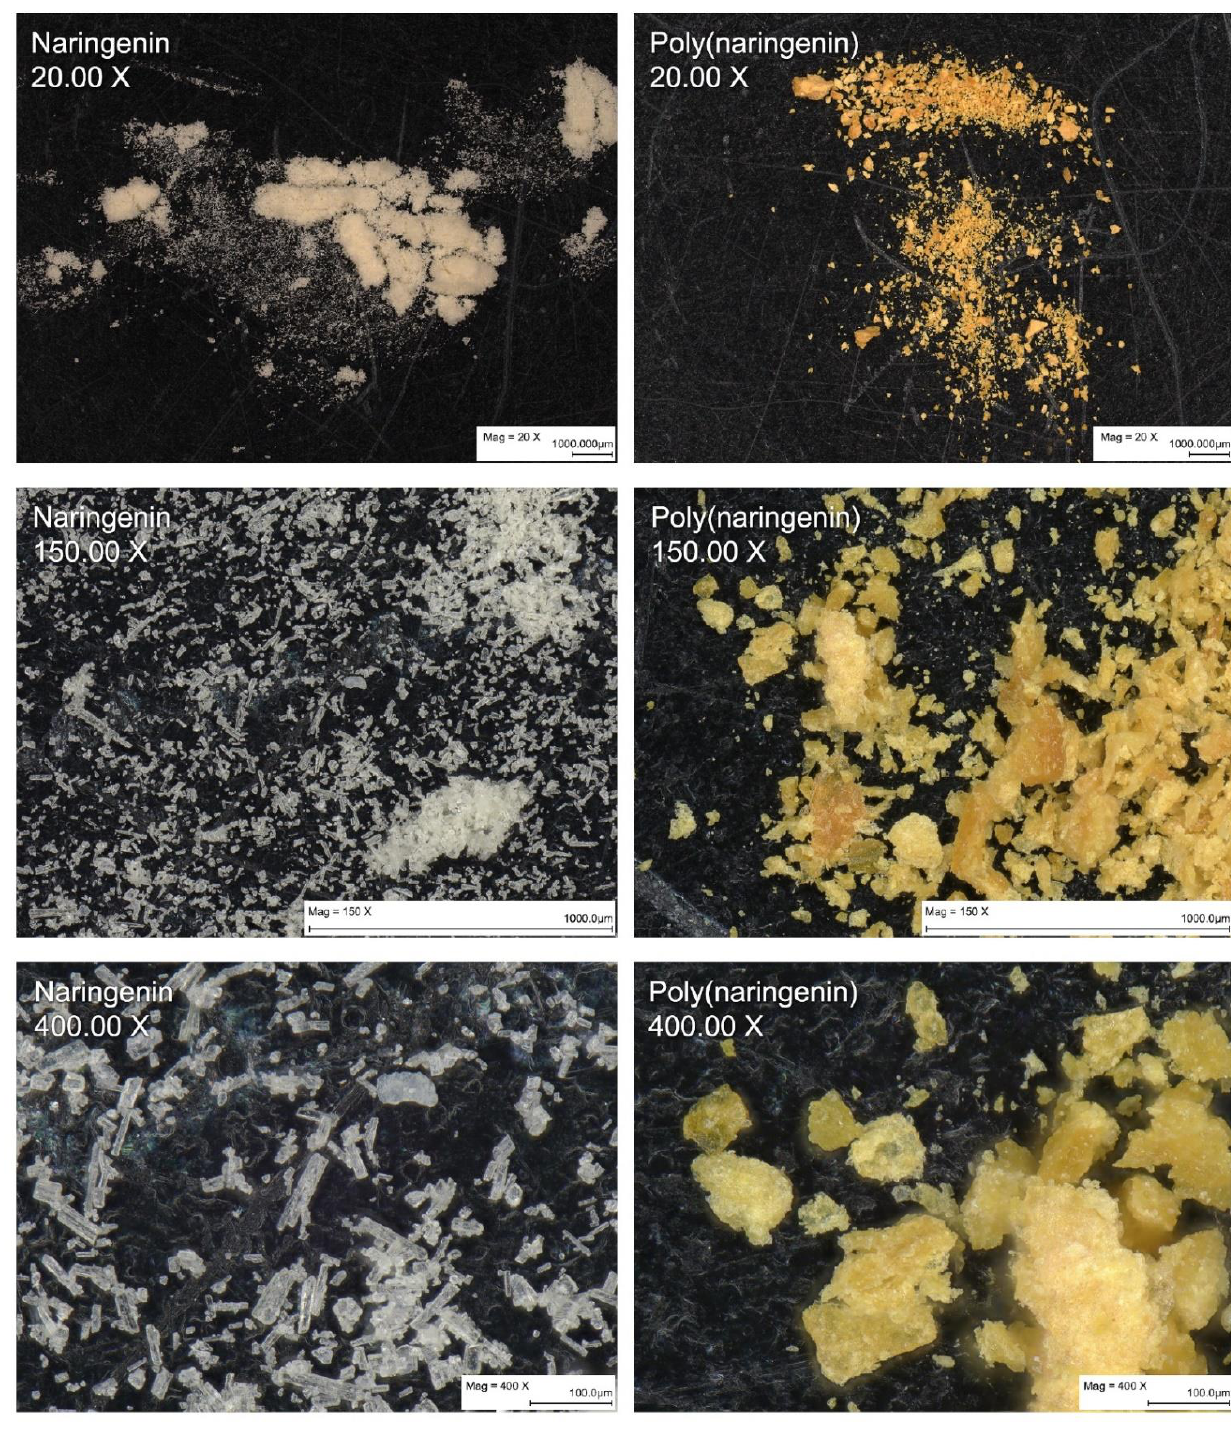
Figure 3. Digital microscope images of naringenin and polymeric naringenin at 20×, 150× and 400× magnification.